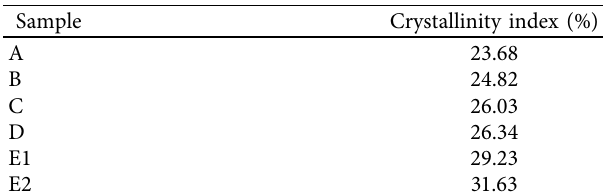
Figure 4: XRD pattern of extracted cellulose for (A) untreated, (B) dewaxing, (C) alkali, (D) dilute acidic, (E1) first bleaching, and (E2) second bleaching-treated sugarcane bagasse. Table 4: Crystallinity index of the